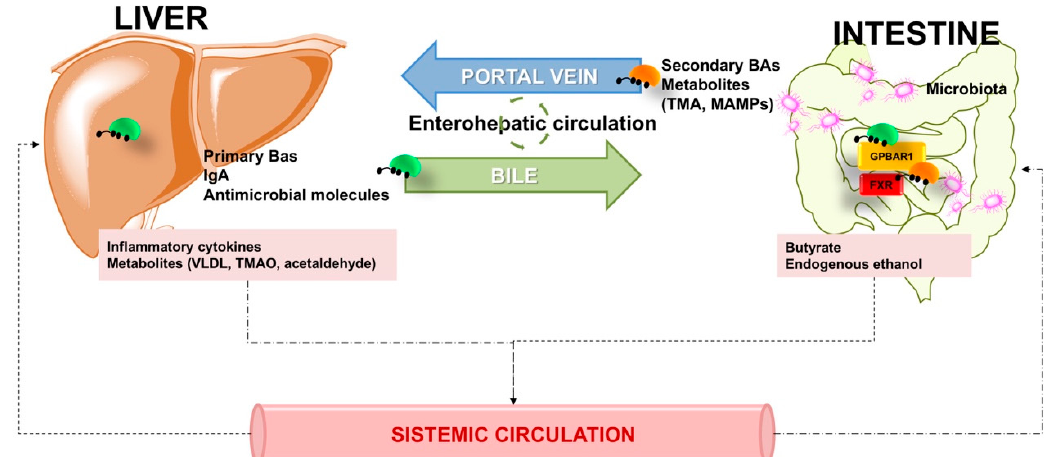
Figure 1. The communication between the liver and the gut is bidirectional. The liver secretes primary bile acids and antimicrobial molecules (immunoglobulin A (IgA) and angiogenin) into the biliary tract. Molecules reach the intestinal lumen and contribute to maintenance of gut eubiosis (while inhibiting intestinal bacterial overgrowth). During the enterohepatic circulation of bile, BAs act as signalling molecules by interacting with the nuclear receptor farnesoid X receptor (FXR) and the G protein-coupled bile acid receptor (GPBAR1). This interaction contributes to modulate hepatic bile acid synthesis, glucose metabolism, lipid metabolism and dietary energy utilization. Gut products include host and/or microbial metabolites and microbial-associated molecular patterns (MAMPs). The systemic circulation also plays a role, since products are translocated to the liver via the portal vein and can influence liver functions. The systemic circulation extends the gut–liver axis since liver metabolites from dietary, endogenous or xenobiotic substances (free fatty acids, choline metabolites and ethanol metabolites) are transported to the intestine through the capillary system. This mechanism of continuous recirculation of molecules across blood capillaries can distinctively affect the intestinal barrier. Butyrate, the short chain fatty acids, is protective (i.e. improves the colonic defensive border), while acetaldehyde can activate a barrier damage. Abbreviations: BAs, bile acids; MAMPs, microbial-associated molecular patters; TMA, trimethylamine; TMAO, trimethylamine N -oxide; VLDL, very-low density lipoprotein. Adapted from Tripathi et al. [11] and Di Ciaula et al. [12].